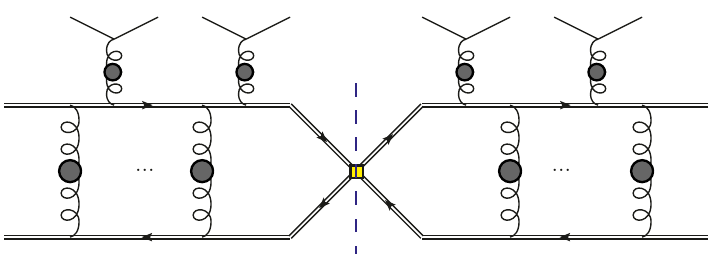
Figure 3 . The diagram represent the thermal average of four-particle operators for the heavy coloured fermion in eq. (3.14). Repeated gluon exchange, represented by the dots, are accompanied by 2 ! 2 scatterings with partons of the medium. These processes are characterised by the small energy scales M F v , M F v 2 , (cid:25)T and m D . The hard annihilation is instead shown with the yellow vertex, which amounts at the matching coe(cid:14)cients that develop an imaginary part. This is implemented by the cut on the diagram with a blue dashed